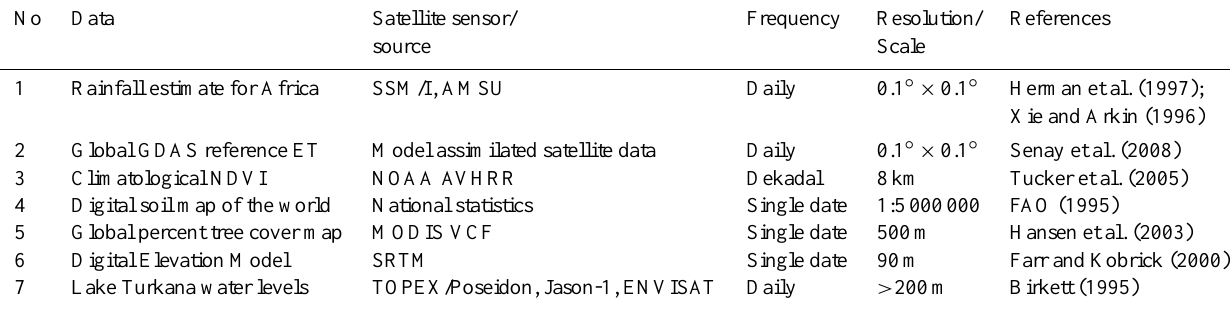
Table 2. Satellite data and products used in the lake level modelling (LLM)